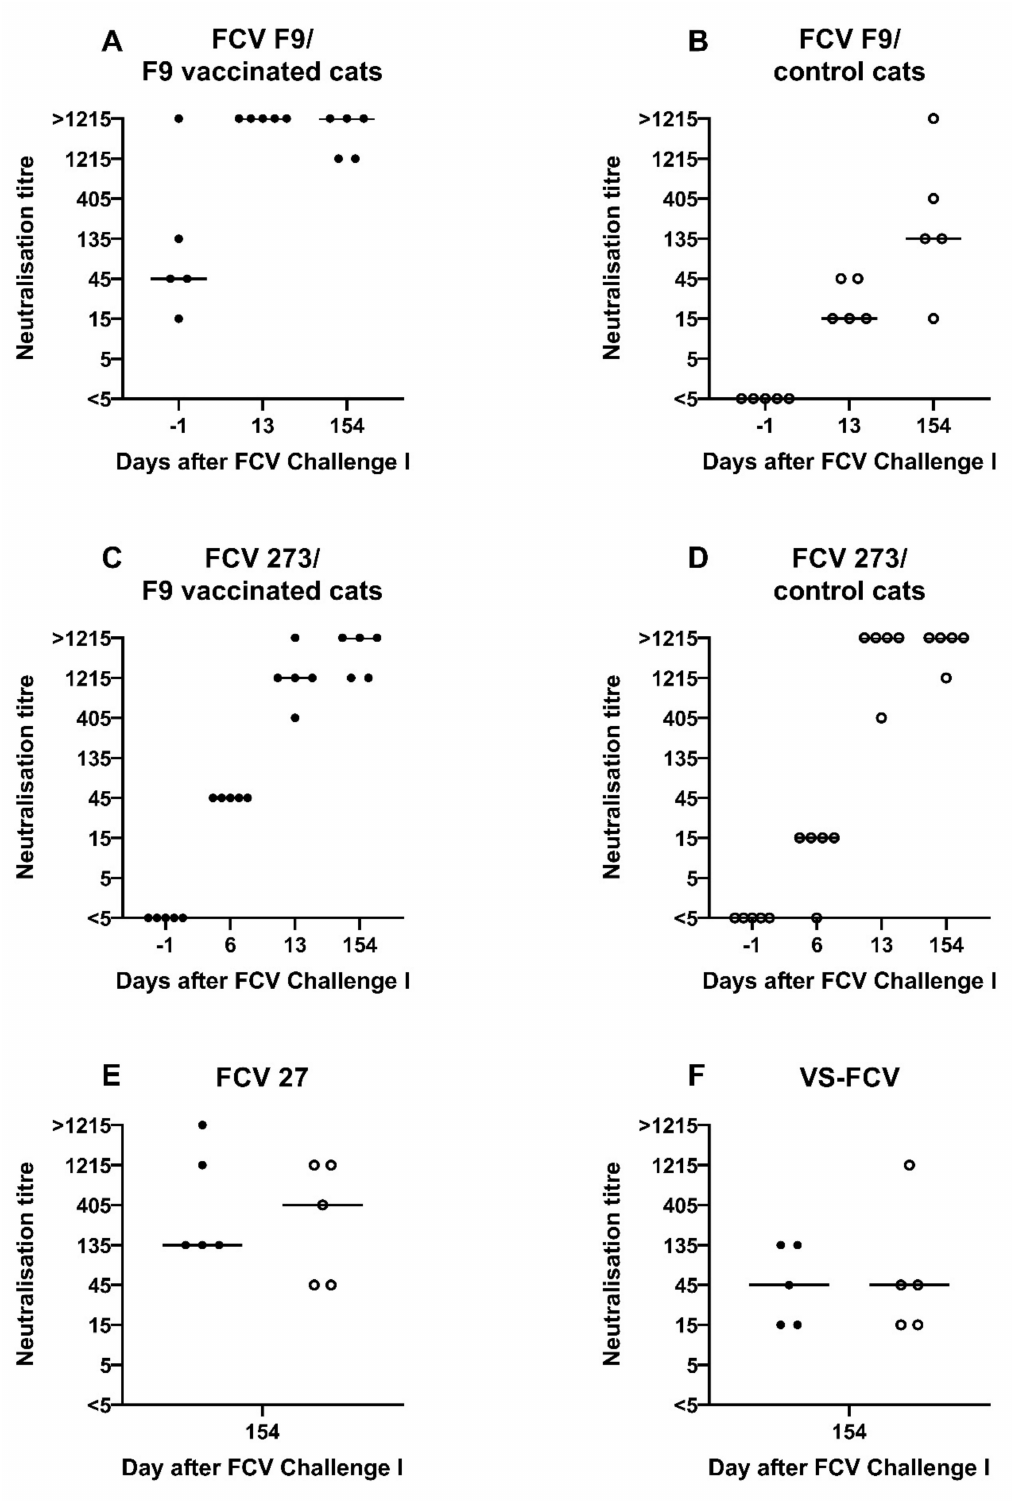
Figure 7. Dot plots of neutralisation titres measured by serum neutralisations assays before and after FCV Challenge I with FCV 273. Each dot represents the titre of a cat of the vaccine or control group, respectively. The titre is the reciprocal of the serum dilution where 50% or more of the wells show a CPE. Dot plot of FCV F9 neutralisation titres in vaccinated cats ( A ) and control cats ( B ), dot plot of FCV 273 neutralisation titres in vaccinated cats ( C ), and control cats ( D ), dot plot of FCV 27 neutralisation titres in vaccinated cats (solid dot) and control cats (open dot) ( E ), and dot plot of virulent-systemic (VS)-FCV-neutralisation titres in vaccinated cats (solid dot) and control cats (open dot) ( F